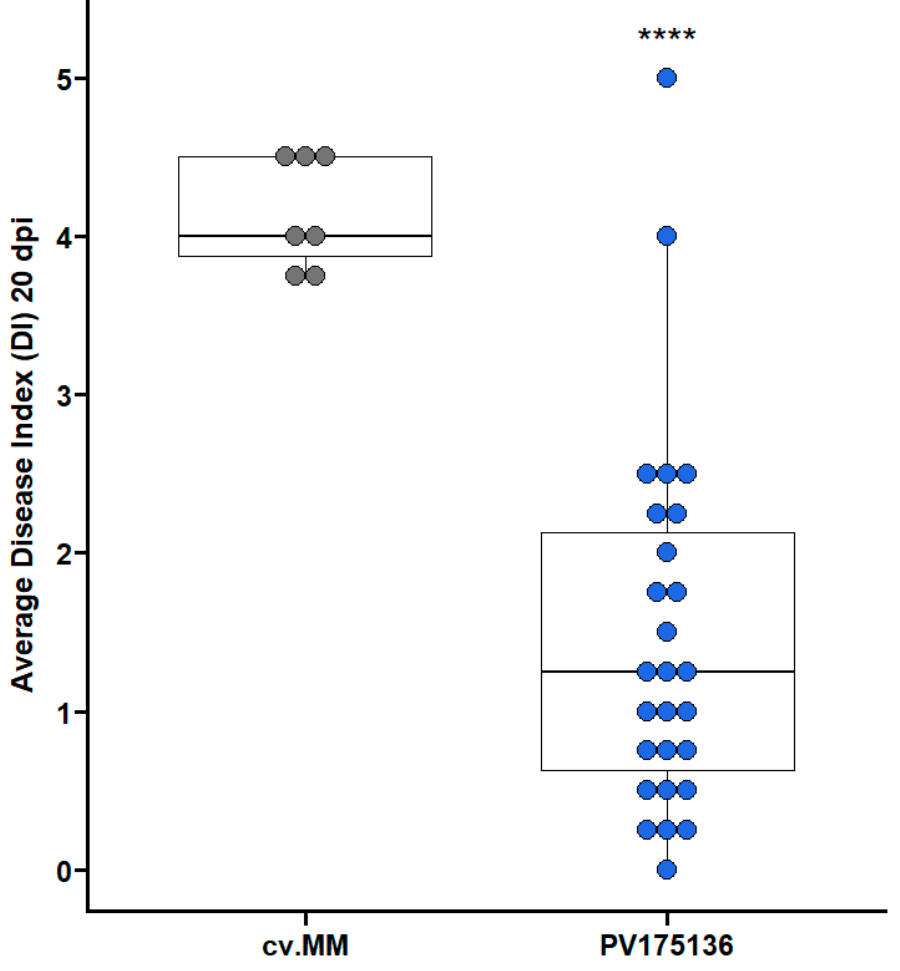
Figure 1. Phenotypic evaluation of line PV175136. Average disease index (DI) of the introgression line PV175136 and the susceptible background cv. MM at 20 days after inoculation with Clavibacter michiganensis NCPBB382. Centre lines indicate medians; the box limits indicate the 25th and 75th percentiles. (Student’s t -test, **** p ≤ 0.00). Table 3. CAPS markers analysis of the QTL on chromosome 7 in line PV185517. In the table, a number of plants with segregating phenotypes is given. A = homozygous for S. arcanum LA2157 allele, M = homozygous for S. lycopersicum cv. MM, S = susceptible, T =